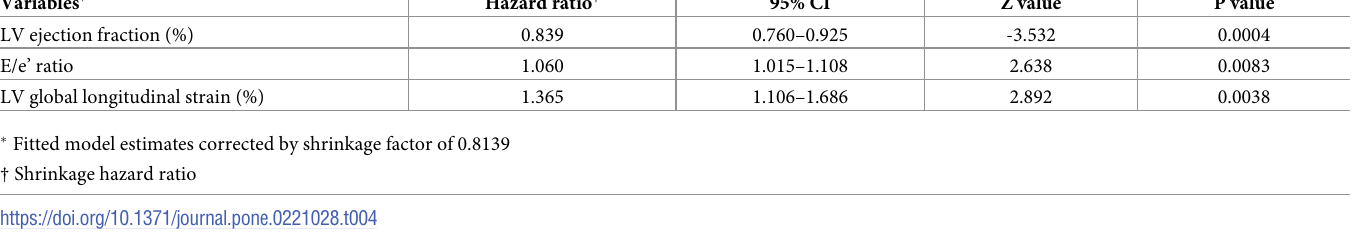
Table 4. Multivariable Cox proportional-hazards analysis for predicting adverse cardiac events in the overall patient population with dilated cardiomyopathy. Variables